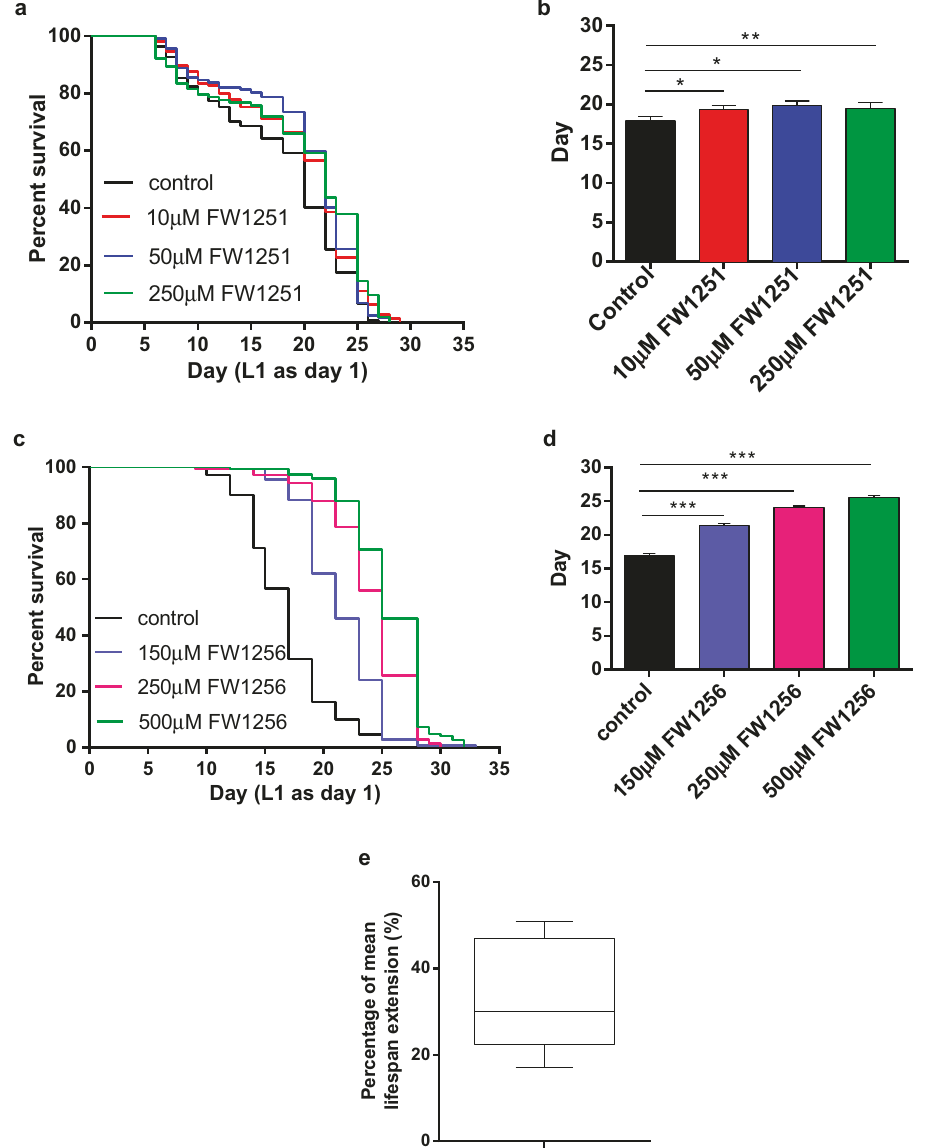
Fig. 1 Effects of FW1251 and FW1256 on lifespan of WT C. elegans . a Survival curves and b mean lifespan of WT C. elegans exposed to different doses of FW1251, n = 103 – 145 animals per condition. c , d Dose – response experiment of FW1256 on lifespan of WT C. elegans , c survival curves, d mean lifespan, n = 111 – 150 animals per condition. e Boxplot showing distribution of mean lifespan extension effects on WT C. elegans upon exposure to 500 µM of FW1256 from the fi ve independent experiments (Supplementary Table 1). In this box plot, the bottom and top of the box represent the 25% percentile and 75% percentile, the center line represents the median and the whiskers encompass the entire range of values for all fi ve independent experiments. (Survival curves were analyzed using log-rank tests while mean lifespans were analyzed using OASIS2, * p < 0.05, ** p < 0.01, *** p <